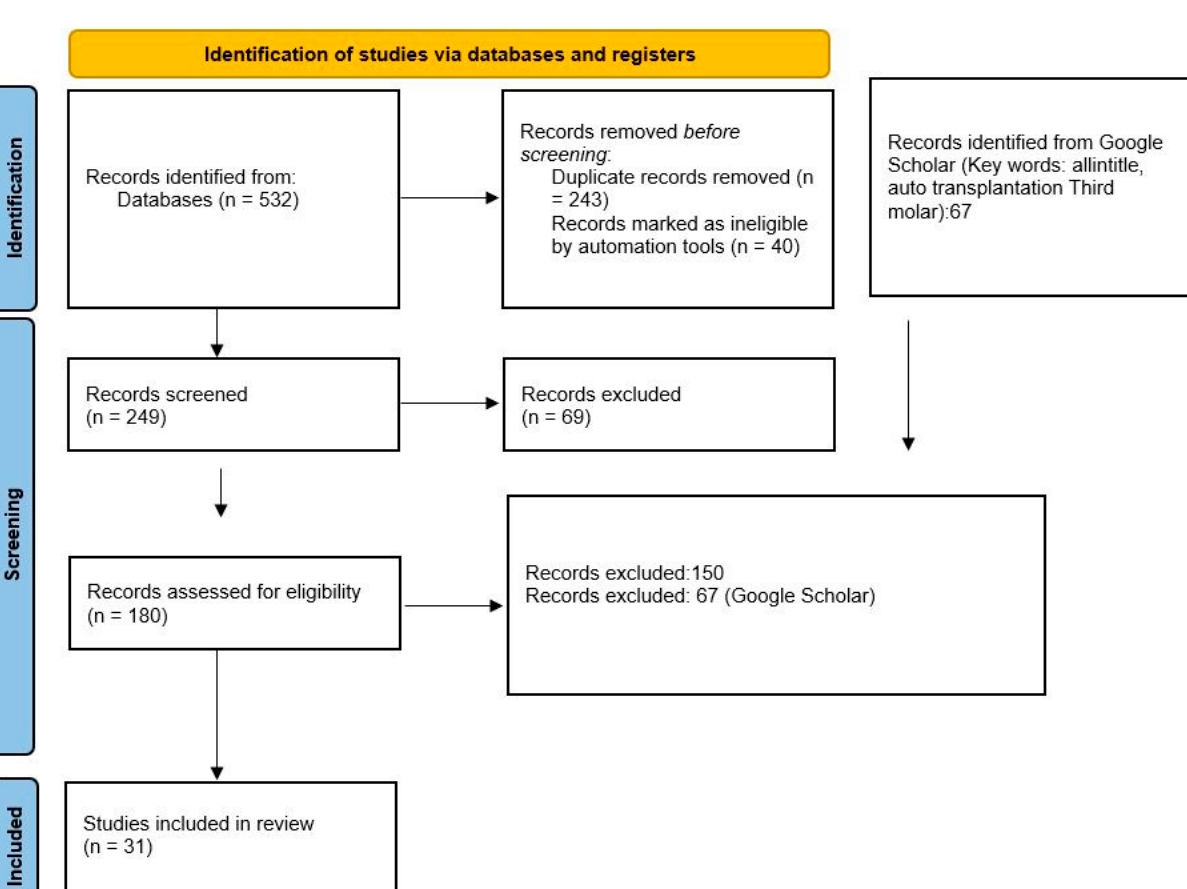
Figure 1. Flow chart of the different phases of the review.